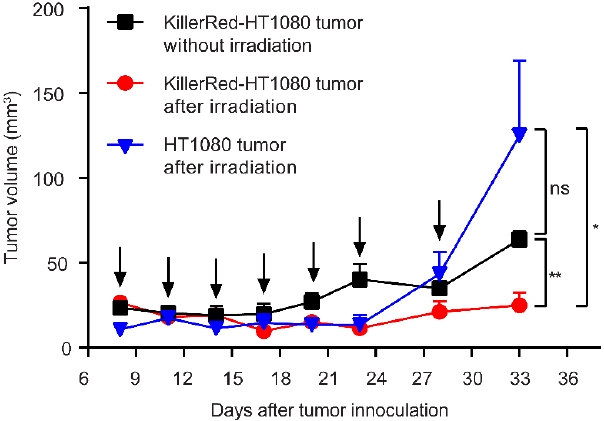
Fig. 3. The tumor volume measurement of the KillerRed- HT1080 tumors and HT1080 tumors. The black arrows indicate the time points at which the mice were treated with light ir- radiation. The scale bars represent Mean (cid:3) SEM. (* p < 0 : 05, ** p < 0 : 01, n ¼